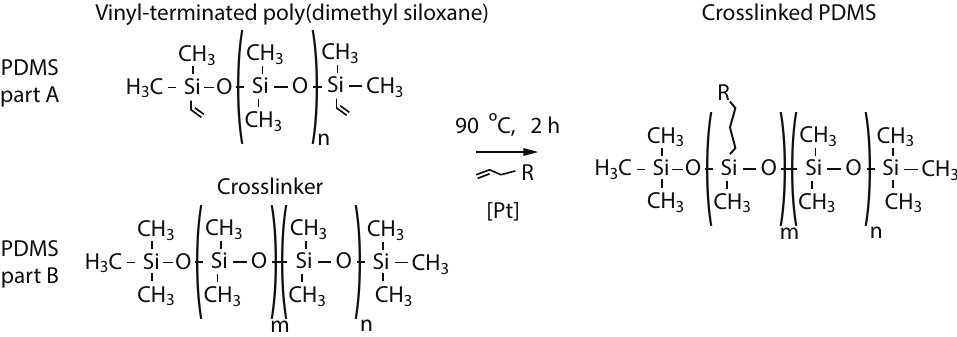
Figure 1. Structure of the polydimethylsiloxane (PDMS): pre-polymer (PDMS part A) and crosslinker (PDMS part B). The crosslinked structure of the polymer (right) is obtained after the alkane reacts with the silicon hydride under the influence of the platinum as a catalyst